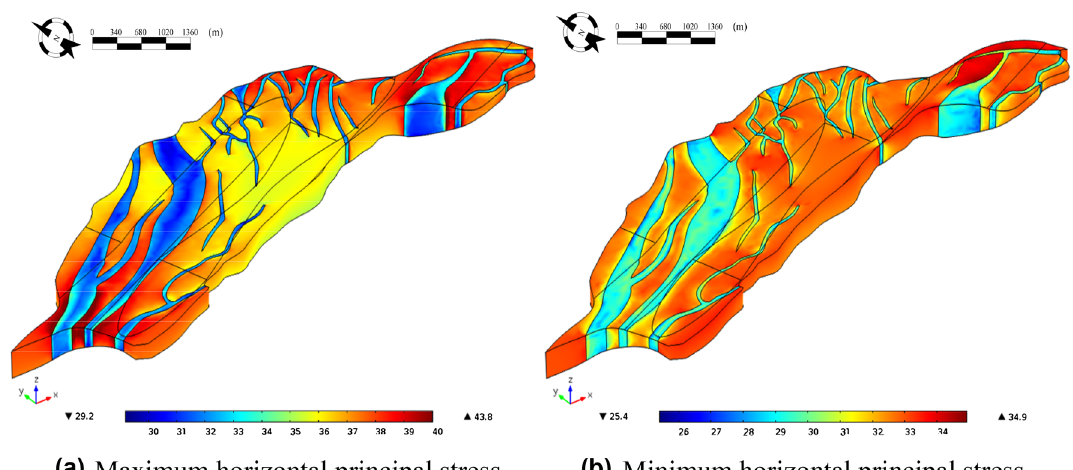
Fig. 1 The geostress inversion of Hailar Bei 14 block II oil group